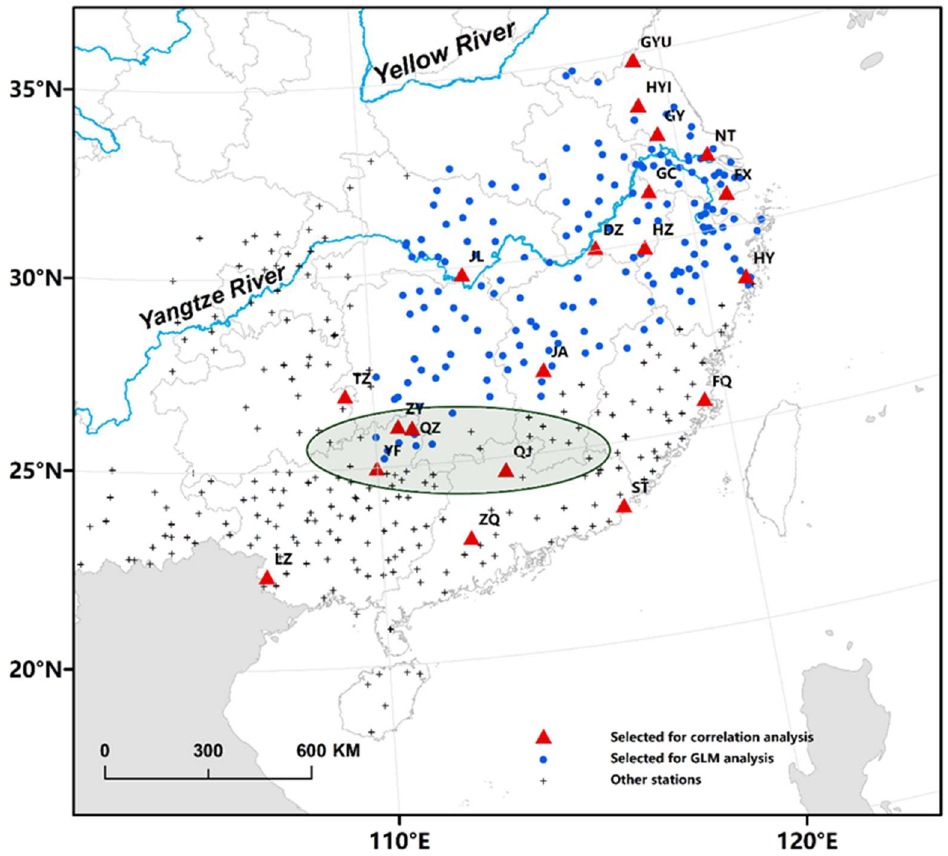
Figure 1. Locations of 222 county plant protection stations (PPS) with white-backed planthopper (WBPH) data (black cross symbol). The representative stations, with complete data from 1978–2003, were selected for further detailed analysis and are represented by red triangles, namely, Longzhou (LZ), Zhaoqing (ZQ), Shantou (ST), Qujiang (QJ), Quanzhou (QZ), Yongfu (YF), Ziyuan (ZY), Tianzhu (TZ), Ji’an (JA), Fuqing (FQ), Jianli (JL), Dongzhi (DZ), Huizhou (HZ), Huangyan (HY), Gaochun (GC), Fengxian (FX), Nantong (NT), Gaoyou (GY), Huaiyin (HYI), and Ganyu (GYU). From 16 May to 15 July, most WBPHs come from the northern part of southern China (approximately 23.5–27° N, green oval area), and we selected Yongfu as a hypothetical starting point. The stations located northeast of Yongfu were selected as the WBPH landing areas (blue dots).